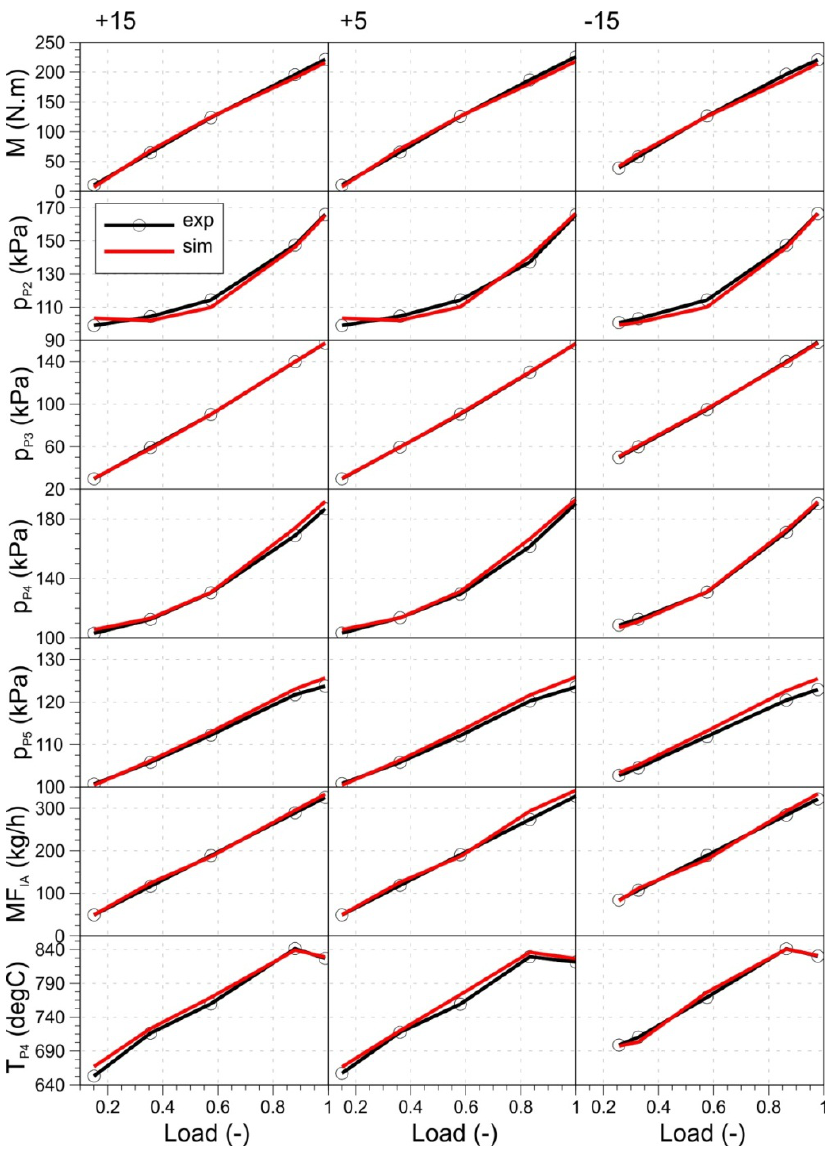
Figure A2. Comparison of simulated and measured torque (M), pressure in P2 (p ), P4 (p ) and P5 (p ) as well as intake mass flow (MF P3 (p P3 P4 P5 P4 (T ) for 4000 rpm and varying engine load and intake camshaft phasing angles that P4 correspond to intake valve opening of 1 mm at +15, +5 and − 15 degree CA after